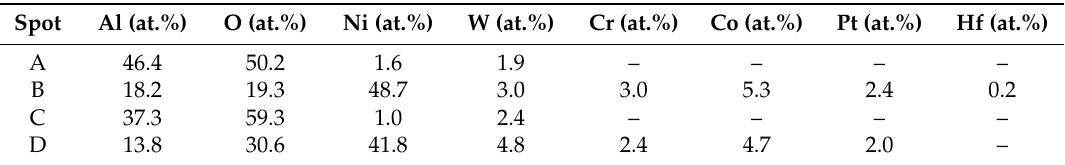
Table 1. Elemental compositions of four different spots (A, B, C, D) on the surface images (Figure 10) of the PtAl and PtZrAl coatings after oxidation for 320 h.